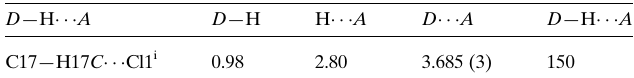
Table 1 Hydrogen-bond geometry (A˚ , (cid:2) ).